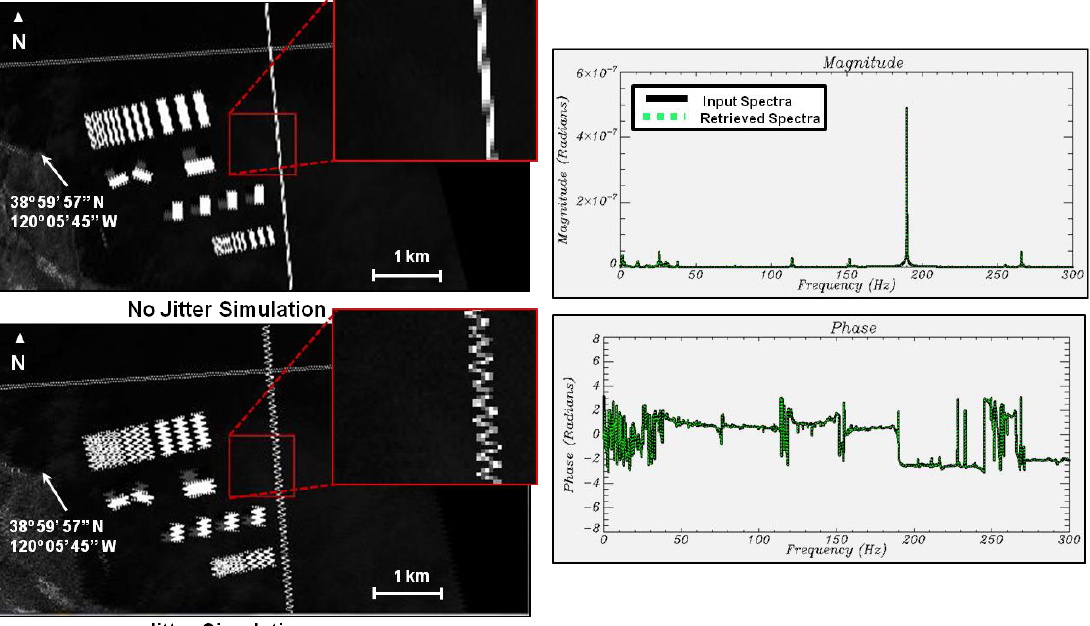
Figure 7. Left column shows simulated OLI imagery produced during algorithm development and testing. A high magnitude jitter was applied in the cross-track direction for visual comparison to the “no jitter” case. The right column shows a validation of the DIRSIG jitter model by comparing the input spectra to the spectra derived from the DIRSIG generated angular data (Note the data sets sit on top of each